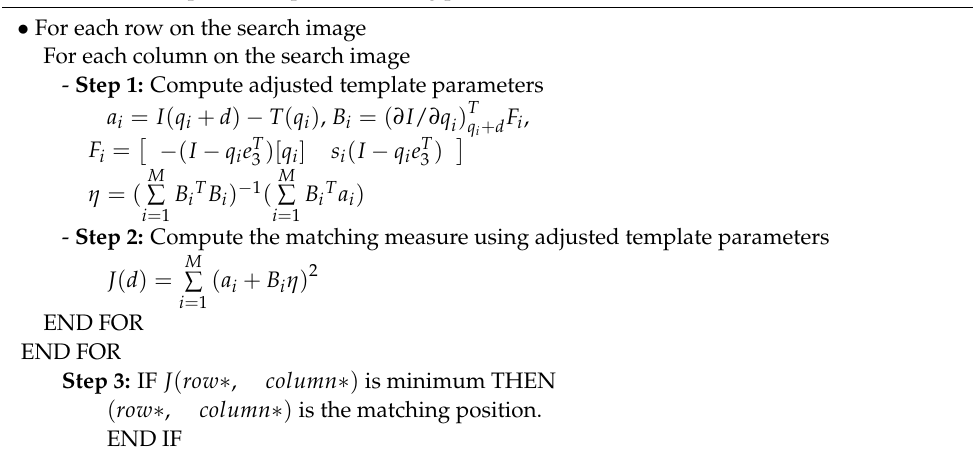
Algorithm 1. Proposed template matching